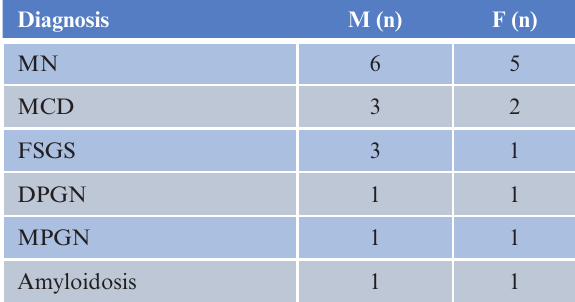
Table 3: Comparison of the biopsy spectrum of males and females in the